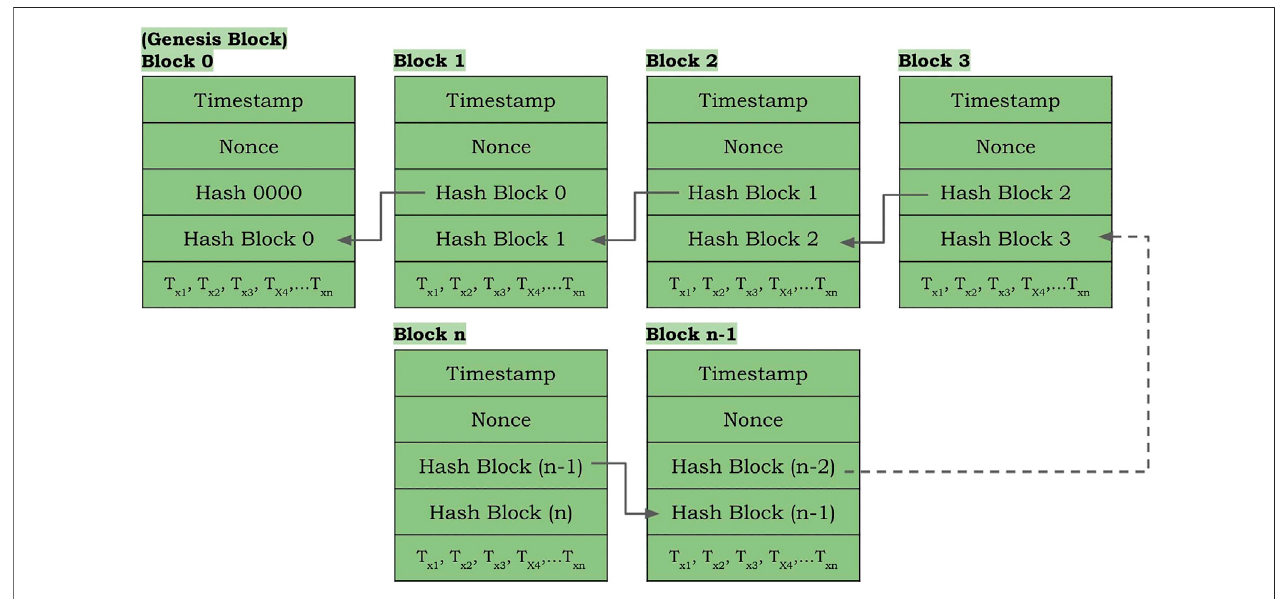
FIGURE 2 | A blockchain